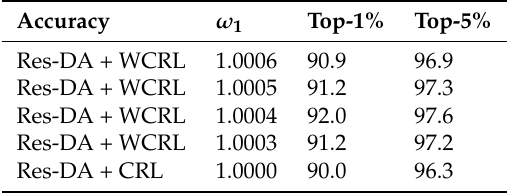
Table 7. Speaker identification results on the VoxCeleb1 dataset with different ω 1 while keeping ω 2 = 1. WCRL, Weighted Cluster-Range